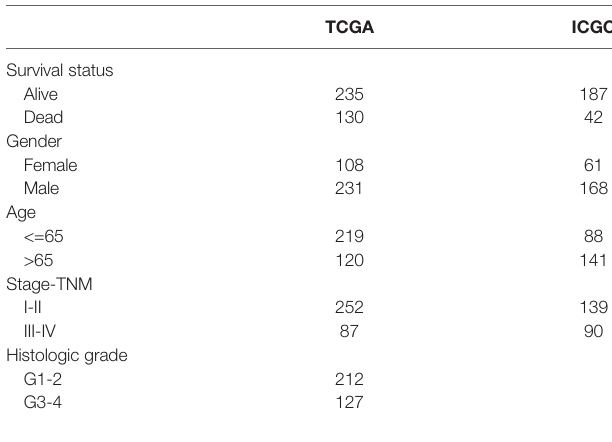
TABLE 1 | The clinical information of TCGA and ICGC